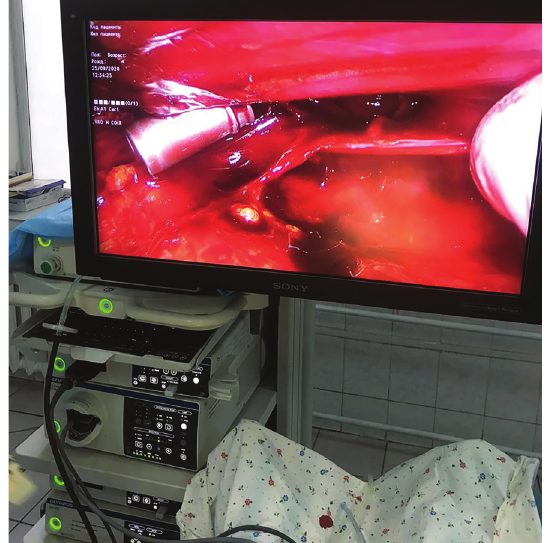
Figure 3 - Palpation of the lower epigastric vessels from the